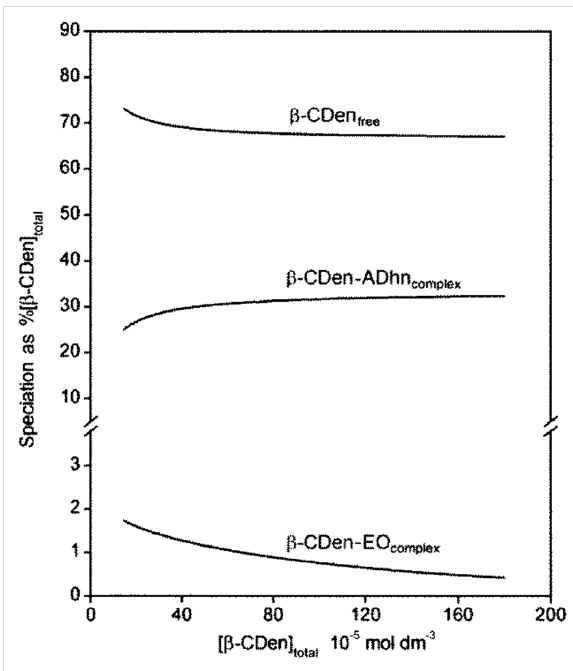
Figure 8: Speciation plot with [ β -CDen] total = 100% for the PAA β - CDen/PAAADhn/EO system.